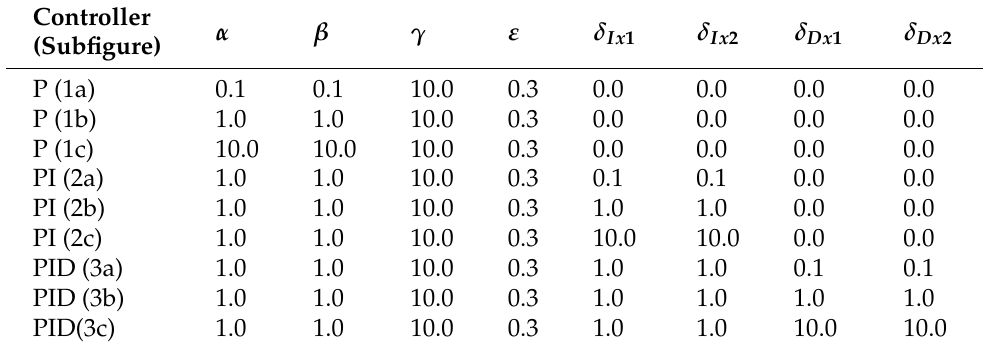
Table 3. Coefficient list for position tracking error plots from Figure 10.